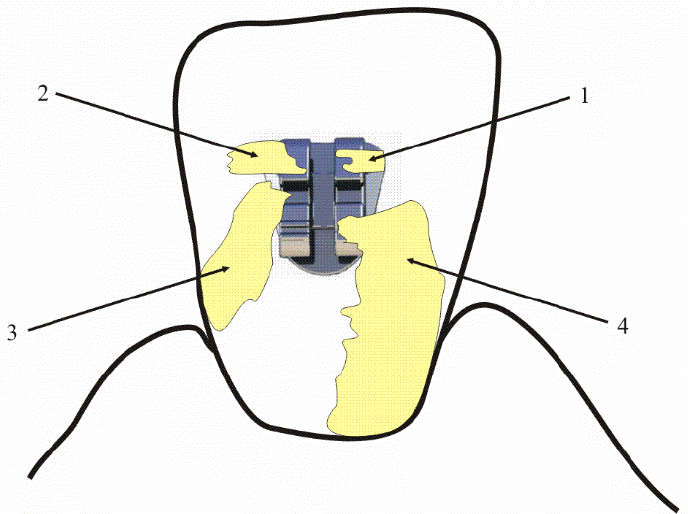
Figure 3. Schematic representation of the BBI: 1—plaque present on the bracket only; 2—plaque present on the bracket and the immediate adjacent tooth surface; 3—plaque present on the bracket and continuous to the interproximal surface; 4—a continuous layer of plaque extending from the bracket to the gingival margin.